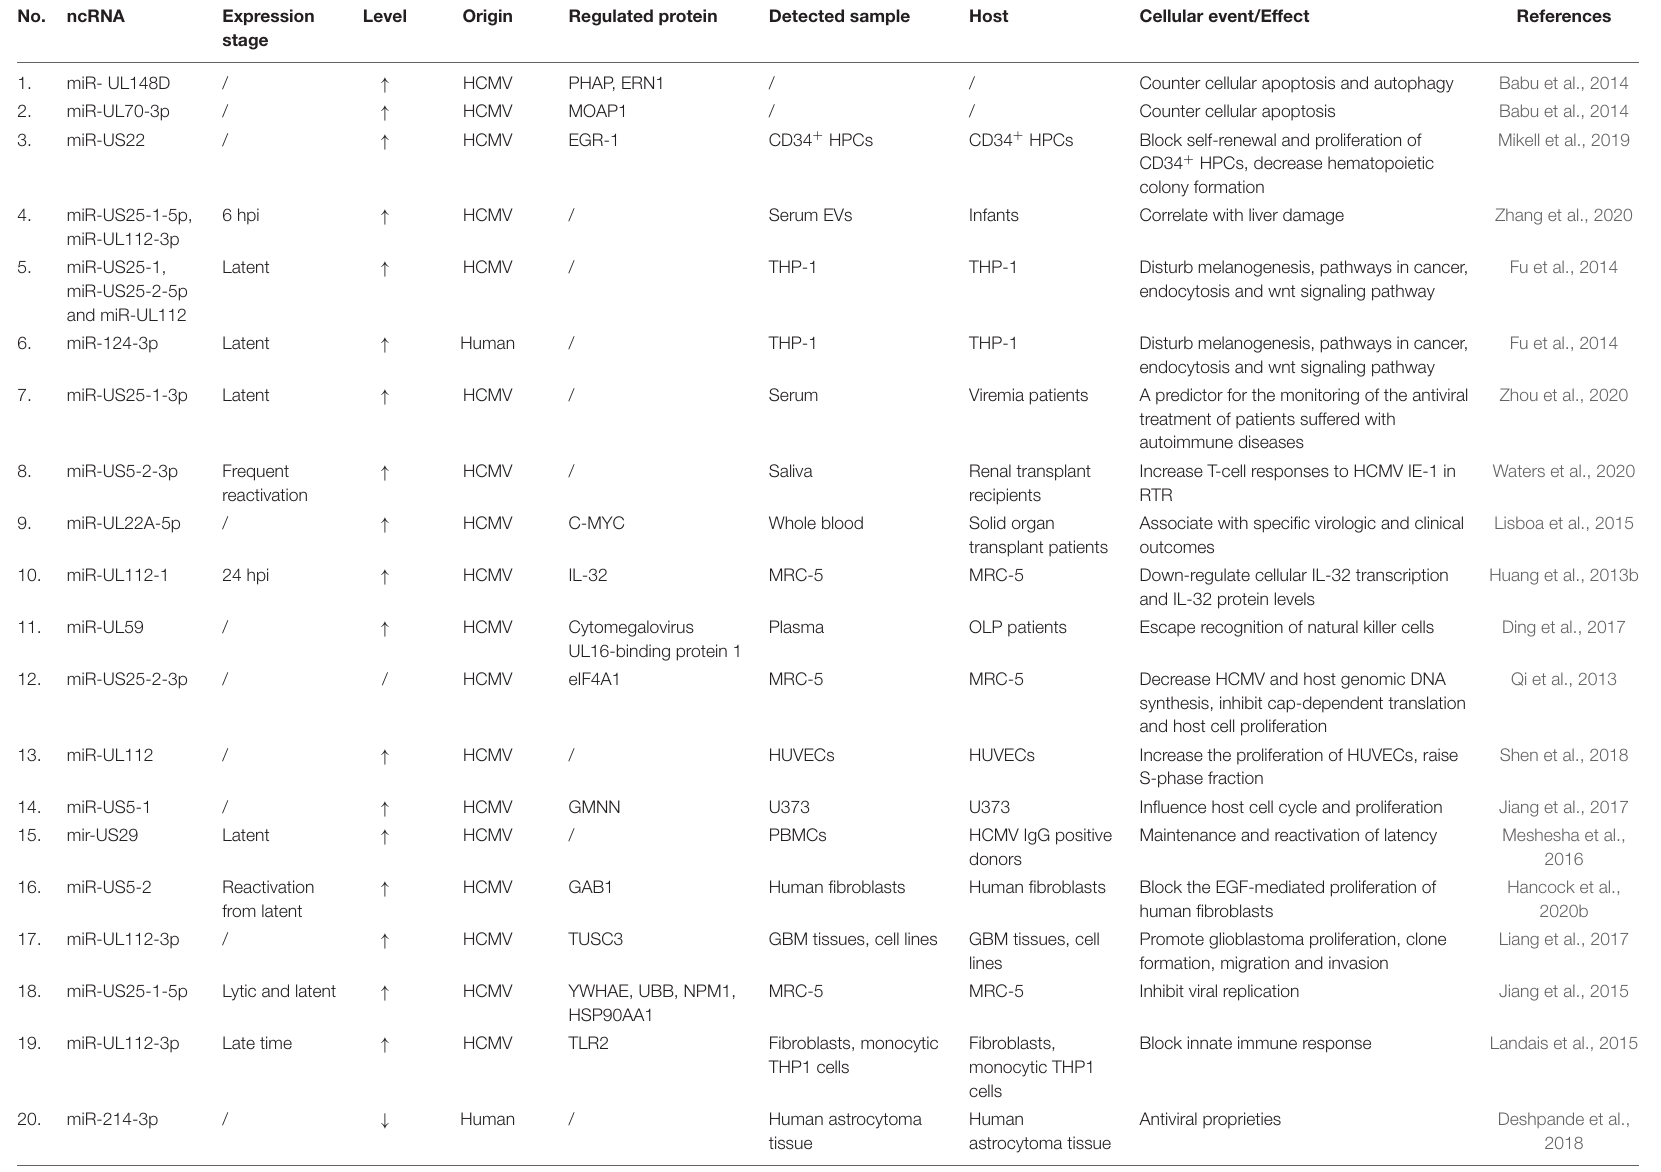
TABLE 1 | The aberrant expression of non-coding RNAs and cellular events induced by